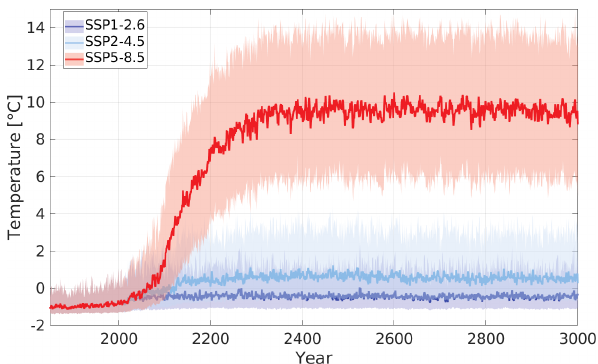
Figure 3. Volume of pan-Arctic SSPF ice for the scenario and control experiments. Grey shading marks the historical